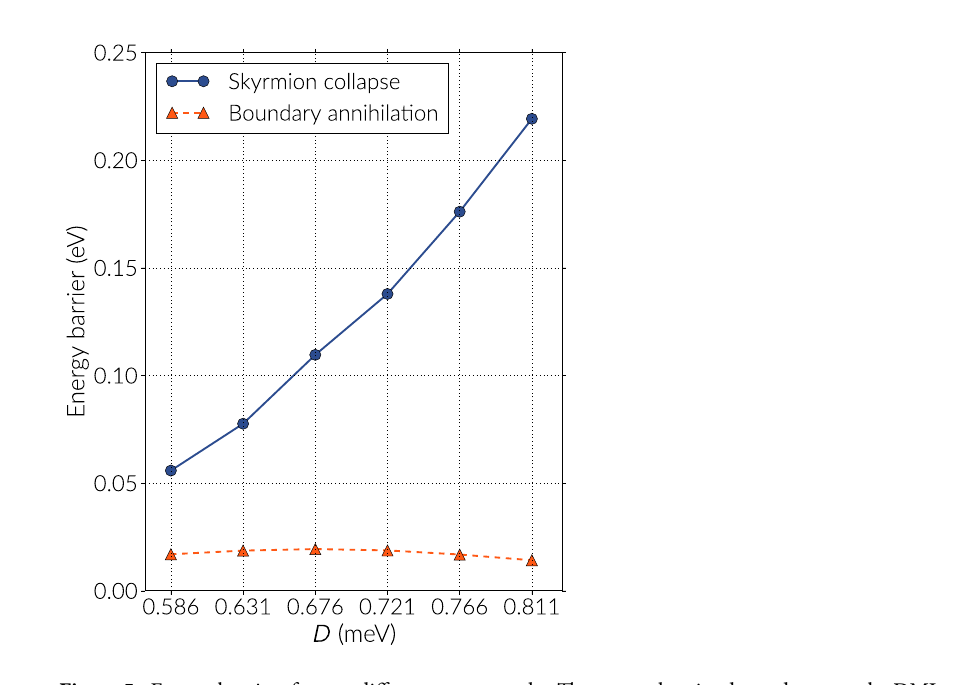
Figure 5. Energy barriers for two different energy paths. The energy barrier dependence on the DMI constant is shown for skyrmion collapse and skyrmion annihilation at the boundary. The energy barriers are calculated with respect to the skyrmion energy and using a cubic polynomial interpolation on the images of the energy bands.